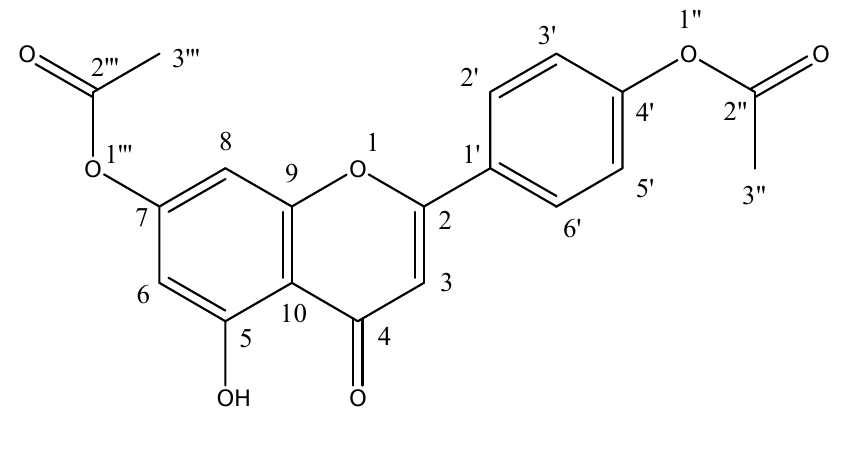
Figure 1. Chemical structure of 4 ′